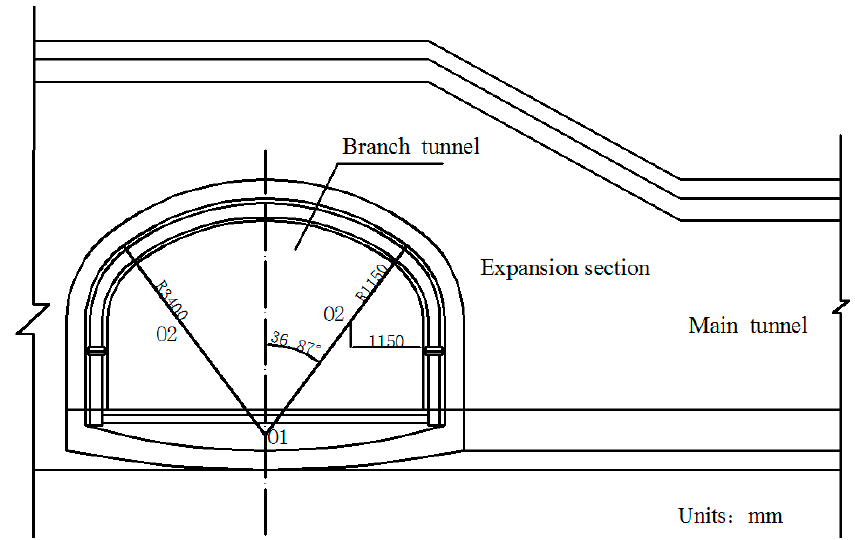
Figure 1. Sketch map of cross section of tunnels.